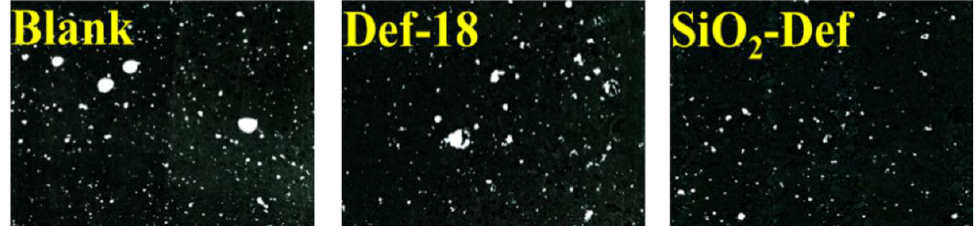
Figure 12. Air-void images of the hardened cement mortar specimens of blank, Def-18, and SiO 2 -